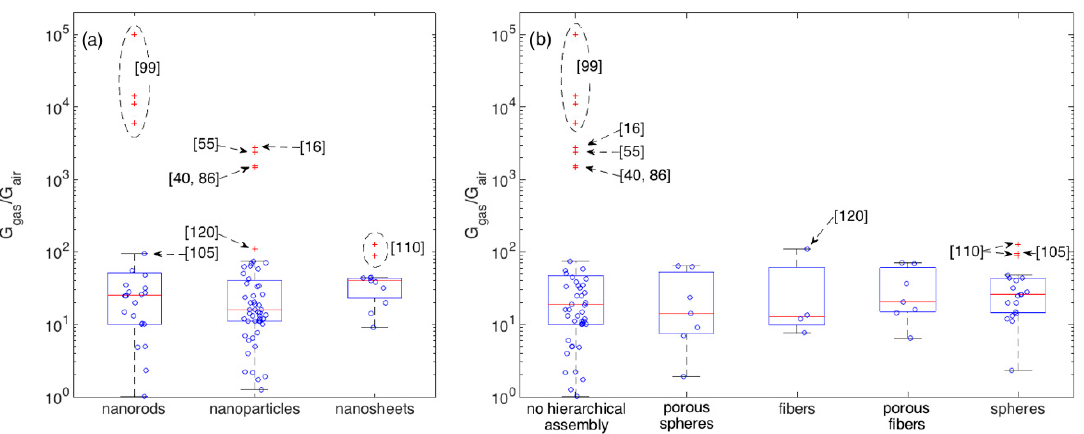
Figure 6. Boxplots showing the statistics of the response amplitude to 100 ppm of ethanol with respect to crystallite morphologies ( a ) and their eventual hierarchical assembly ( b ). Boxplots shows the following parameters: median (central red-mark), 1st and 3rd quartiles (bottom and top box-edges), extreme data not considered outliers (whiskers ends), outliers are individually reported as red crosses, other data-points are visualized as blue circles.